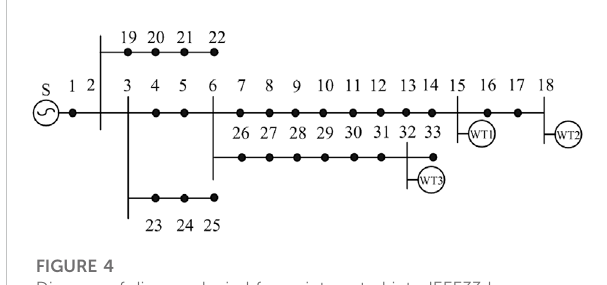
FIGURE 4 Diagram of dispersed wind farms integrated into IEEE33 bus distribution system.